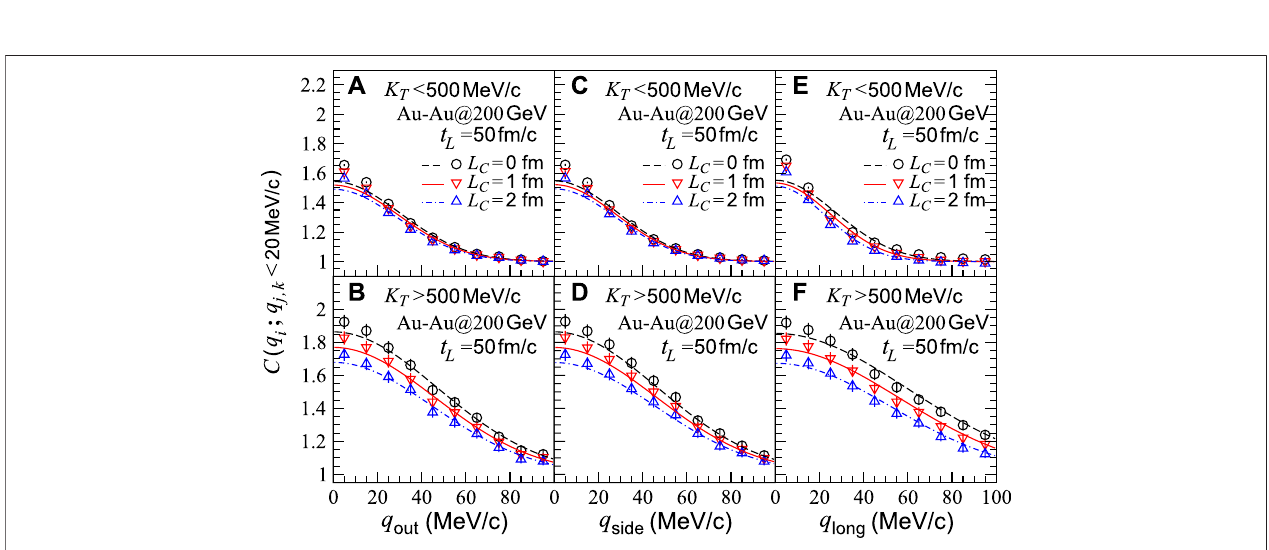
FIGURE 5 | Two-pion correlation functions with respect to relative momenta q i , j , k ( i , j , and k = out, side, and long) for sources in central Au-Au collisions at (cid:1)(cid:1)(cid:1)(cid:1) √ (cid:3) 200 GeV and with t s NN L = 50 fm/ c . Upper panels plot transverse momentum range K T and down-triangle symbols denote coherent emission lengths L C = 0, 1, and 2 fm, respectively. Lines are fi tted curves.